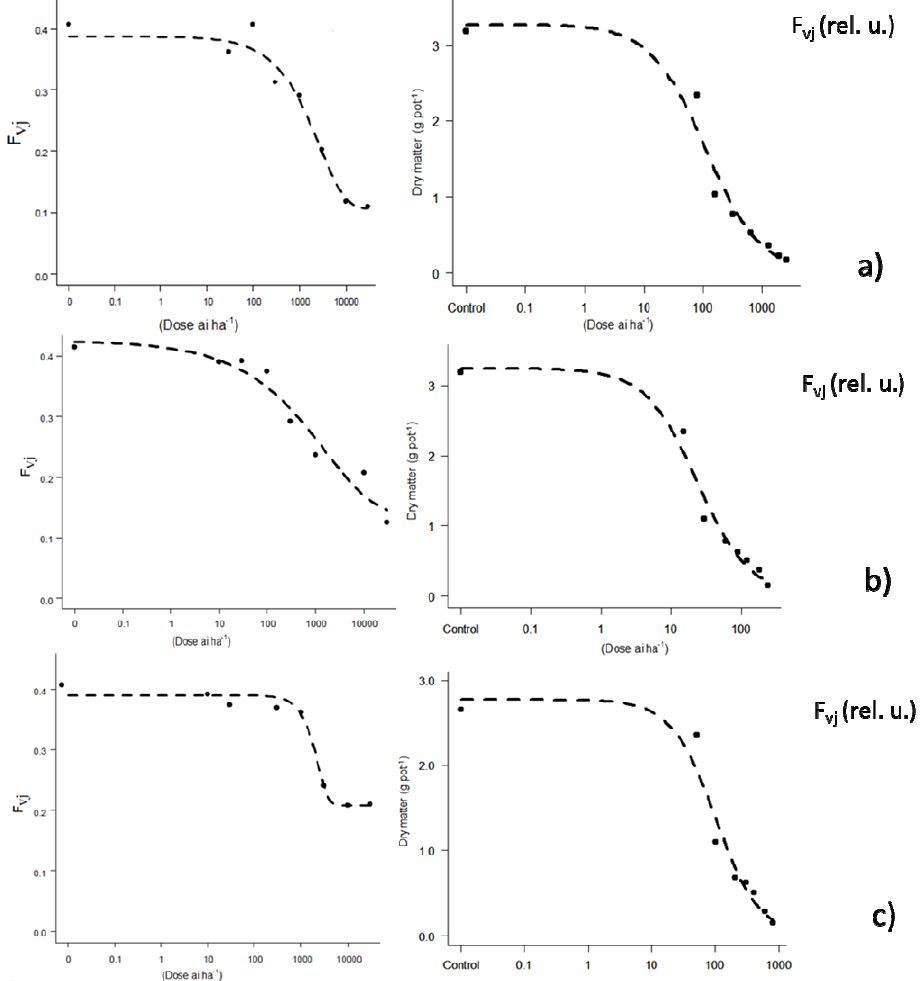
Fig. 4. Dose–response curves for fluorescence 24 h and dry matter 21 days after treatment of Amaranthus retroflexus with chloridazon (a) (experiment 1); Dose–response curves for fluorescence 24 h and dry matter 21 days after treatment of A. retroflexus with clopyralid (b) (experiment 1); Dose–response curves for fluorescence 24 h and dry matter 21 days after treatment of Portulaca oleracea with desmedipham + phenmedipham + ethofumesate (c) (experiment